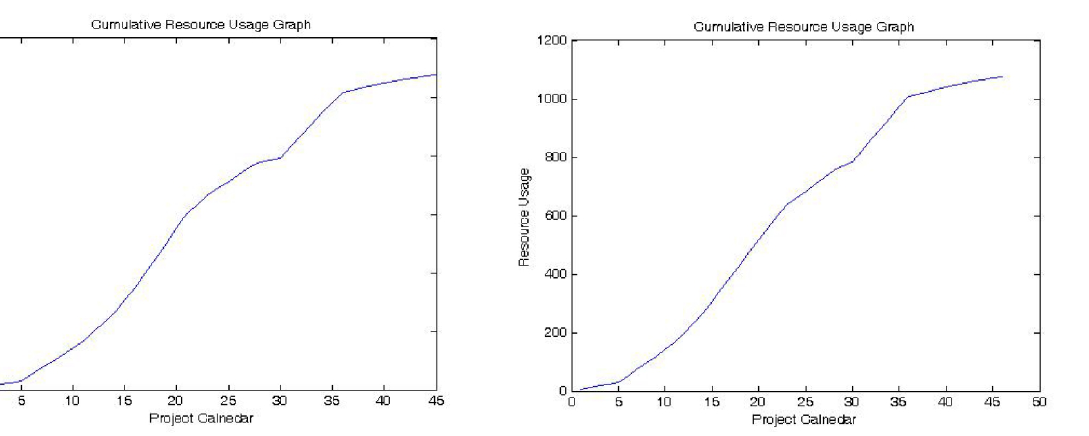
Figure 25. Cumulative resource usage for resource 1 of experiment 2 (relaxed resource constraint)